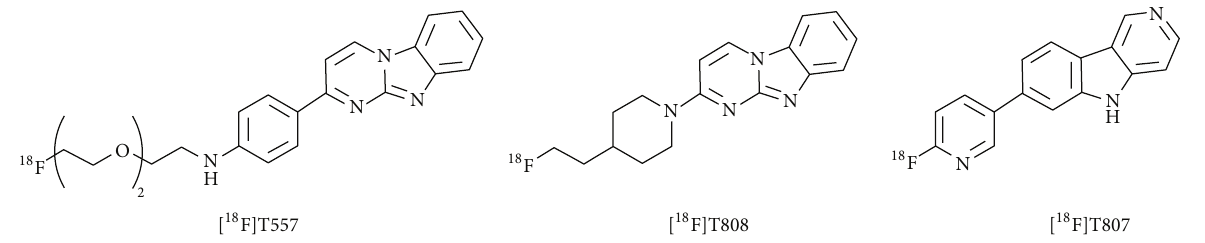
Figure 3: Chemical structures of benzoimidazopyrimidine and pyridoindole derivatives for the imaging of tau [24, 25].